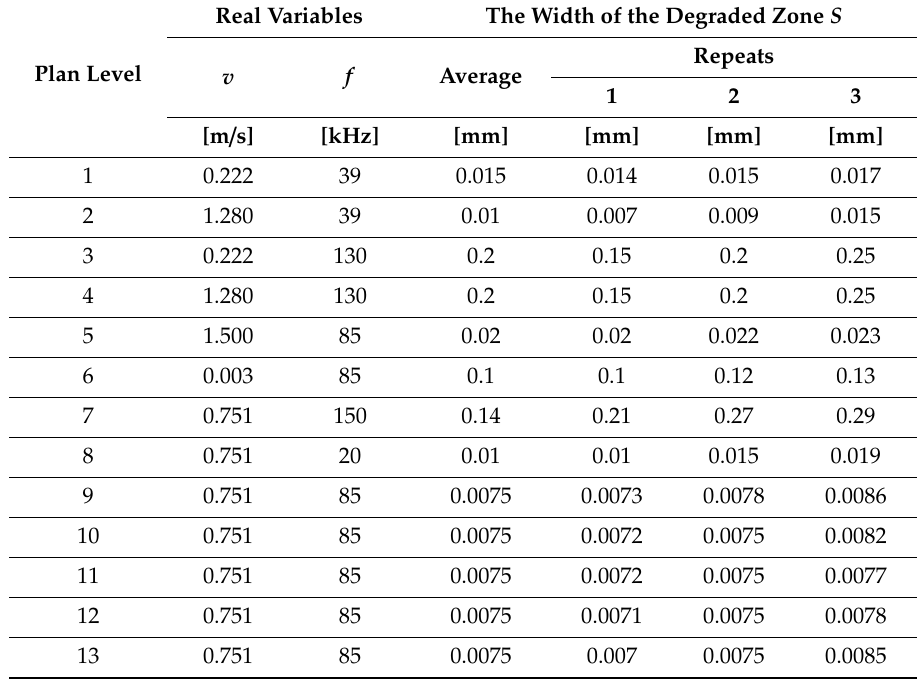
Table 5. The matrix of the experiment plan according to the five-level plan with the results for the film thickness t = 60 µ m.